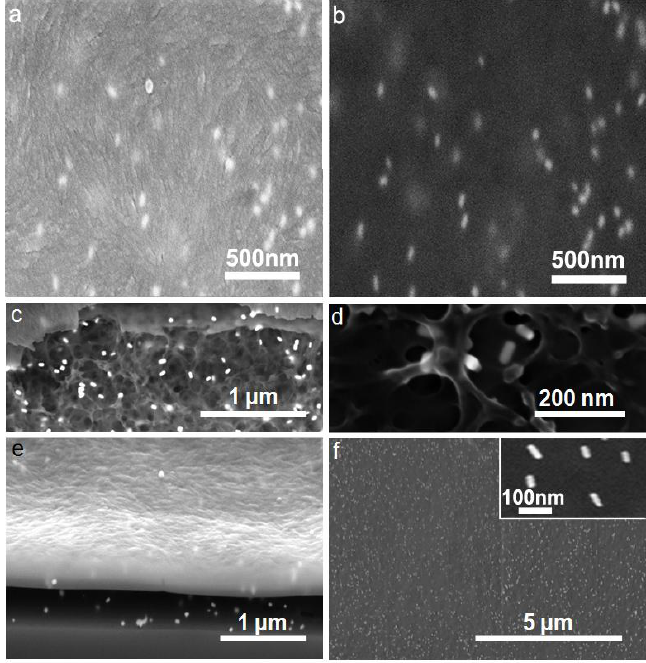
Figure 3. SEM imaging of thin films of CNCs with embedded GNRs (with a thin carbon coat to improve conductivity). ( a,b ) Co-located images obtained with ( a ) in-lens (IL), and ( b ) energy selective in-lens backscattered detector (ESB), detectors at 5 kV, allowing for simultaneous visualization of the unaligned CNC orientation field and the orientation of GNRs embedded in the film. ( c ) Everhart-Thornley (ET) imaging at low resolution and ( d ) IL imaging at high resolution reveal an interior network-like structure of the film at the site of a carbon film collapse induced by focused ion beam (FIB) in a nearby region. FIB allows for visualization of the cross-section of the film. ET imaging at 5 kV. ( e ) Tilt corrected for the 54° angle of the FIB milling, shows that the GNRs are distributed inside the bulk of the ~300 nm thick GNR film. The underlying glass substrate is visible in the bottom of the panel. ( f ) Low resolution ET imaging at 500 V demonstrates the long-range order of the film (no carbon layer is present). The inset shows the local orientation of